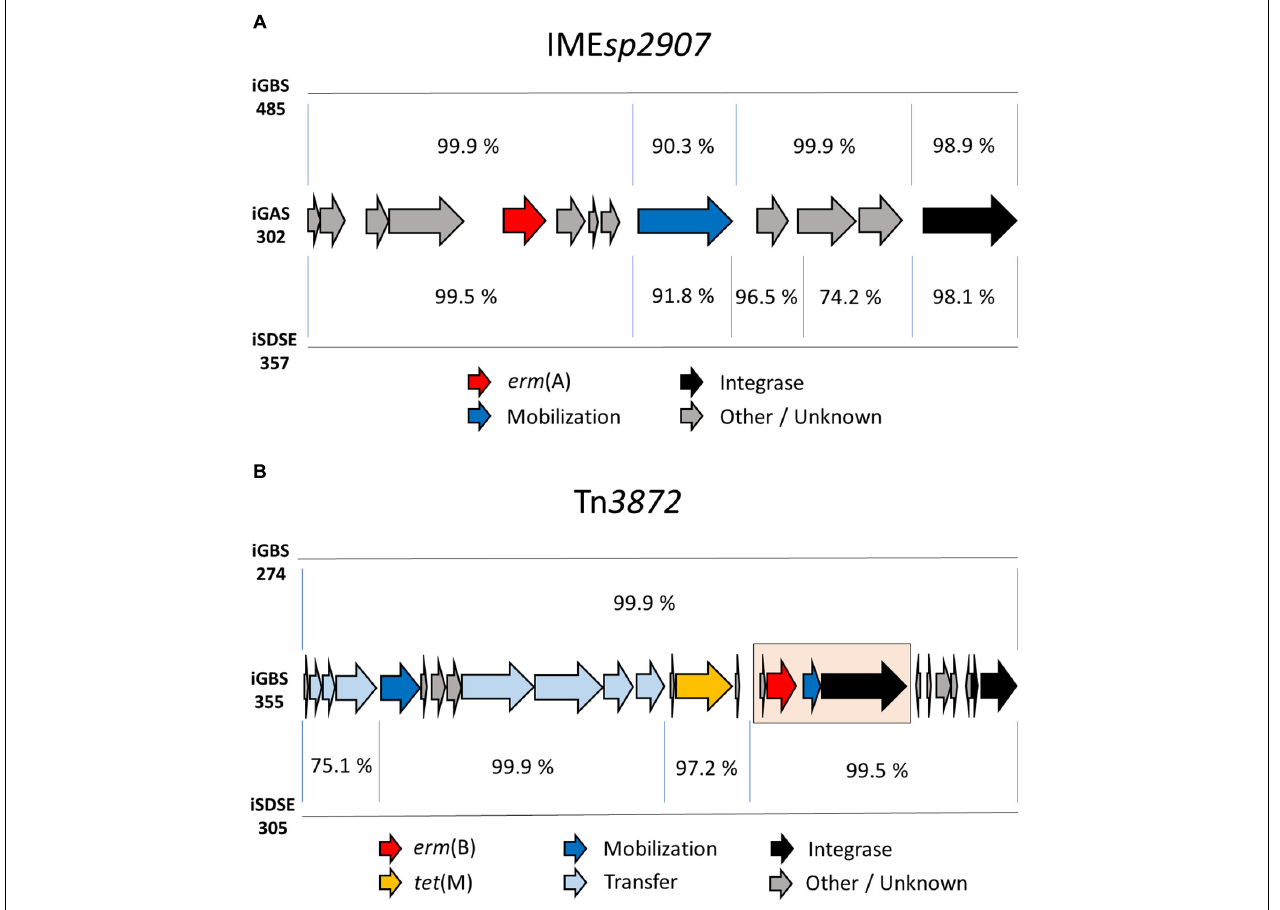
FIGURE 3 | Genetic composition of the mobile genetic element IME sp2907 in three BHS. Mauve was used for the sequence alignment of the mobile genetic element. Panel (A) depicts a comparison of IME sp2907 detected in the invasive BHS isolates iGAS302 ( S. pyogenes ), iGBS485 ( S. agalactiae ), and iSDSE357 ( S. dysgalactiae ). The integrative mobilizable element displayed a conserved genetic architecture and highly similar nucleotide sequences in these three species. Genes involved in mobilization and integration accounted for the majority of the discrepancies. The gene immediately downstream from erm (A) is annotated by RAST as a spectinomycin resistance gene based on sequence similarities, but has not been experimentally verified. Panel (B) displays an alignment of Tn 3872 detected in two GBS isolates and one SD isolate. The ICE Tn 3872 is composed of an erm (B) module (highlighted in a pink box) integrated into a Tn 916